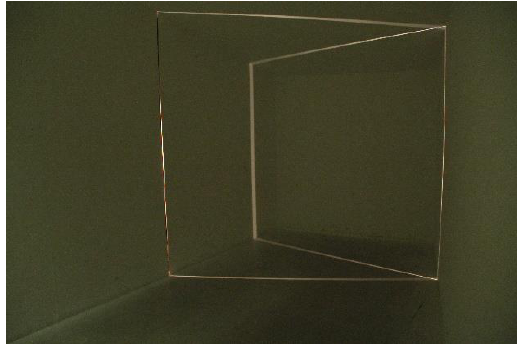
Fig. 1.Internal view of Ambiente - Strutturazione a parametri virtuali . Ambiente - Strutturazione a parametri virtuali by Gabriele Devecchi is a kinetic-programmed environment created in 1969. Gabriele Devecchi (Milan, 1938-2011) has been a member of the italian Gruppo T, a founder group – together with Gruppo N – of Arte Programmata in 1962, mentored by Bruno